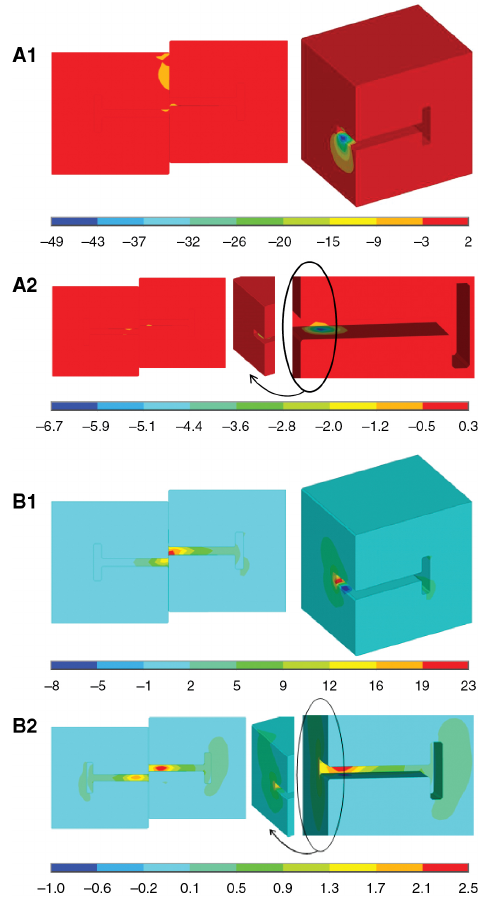
Figure 10: (A) The distribution of the maximum compressive stress in the two epistyles for (A1) the CF- and (A2) the RS- type of specimens. (B) The distribution of the maximum tensile stress in the two epistyles for (B1) the CF- and (B2) the RS-type of